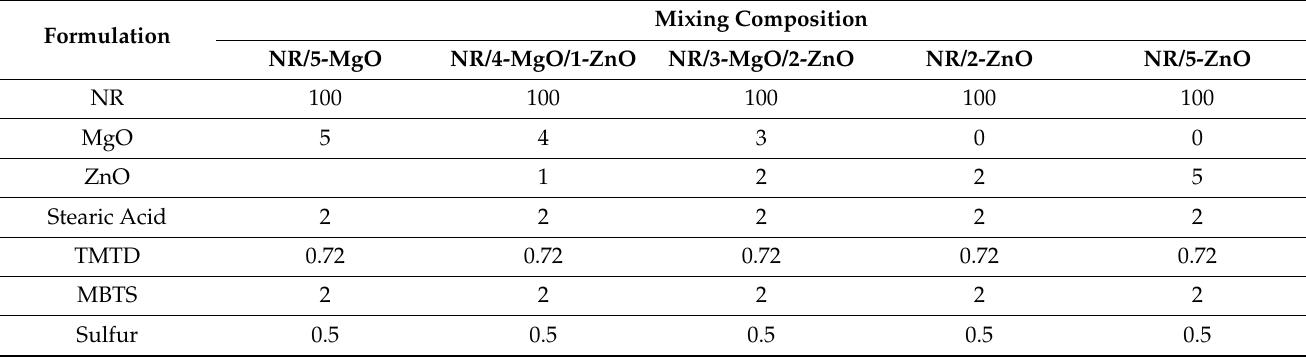
Table 1. Mixing composition of different ingredients in phr (per hundred gram of